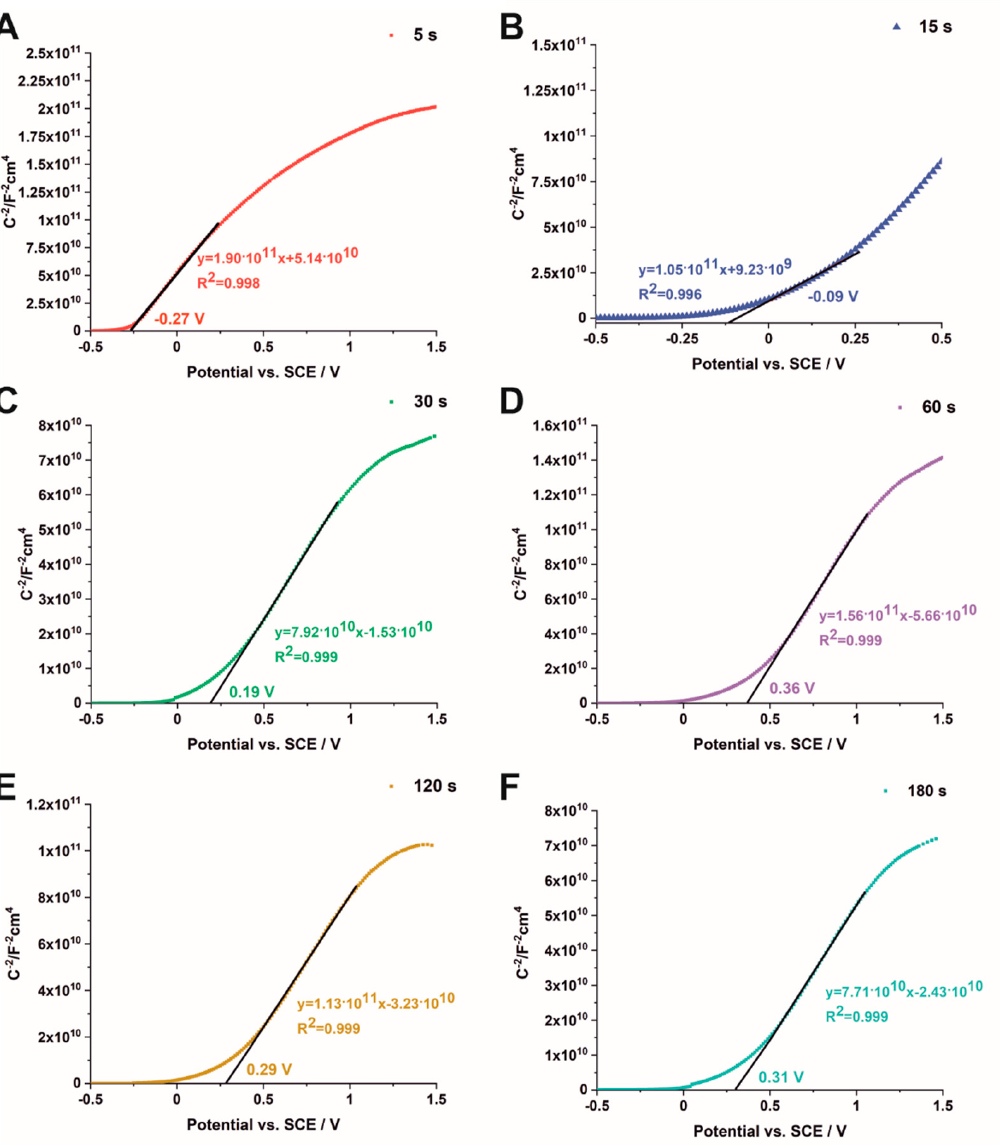
Figure 6. Mott–Schottky plots measured at 1000 Hz for the Fe 2 O 3 –TiO 2 samples obtained by electrodeposition for 5 ( A ), 15 s ( B ), 30 s ( C ), 60 s ( D ), 120 s ( E ), and 180 s ( F ).